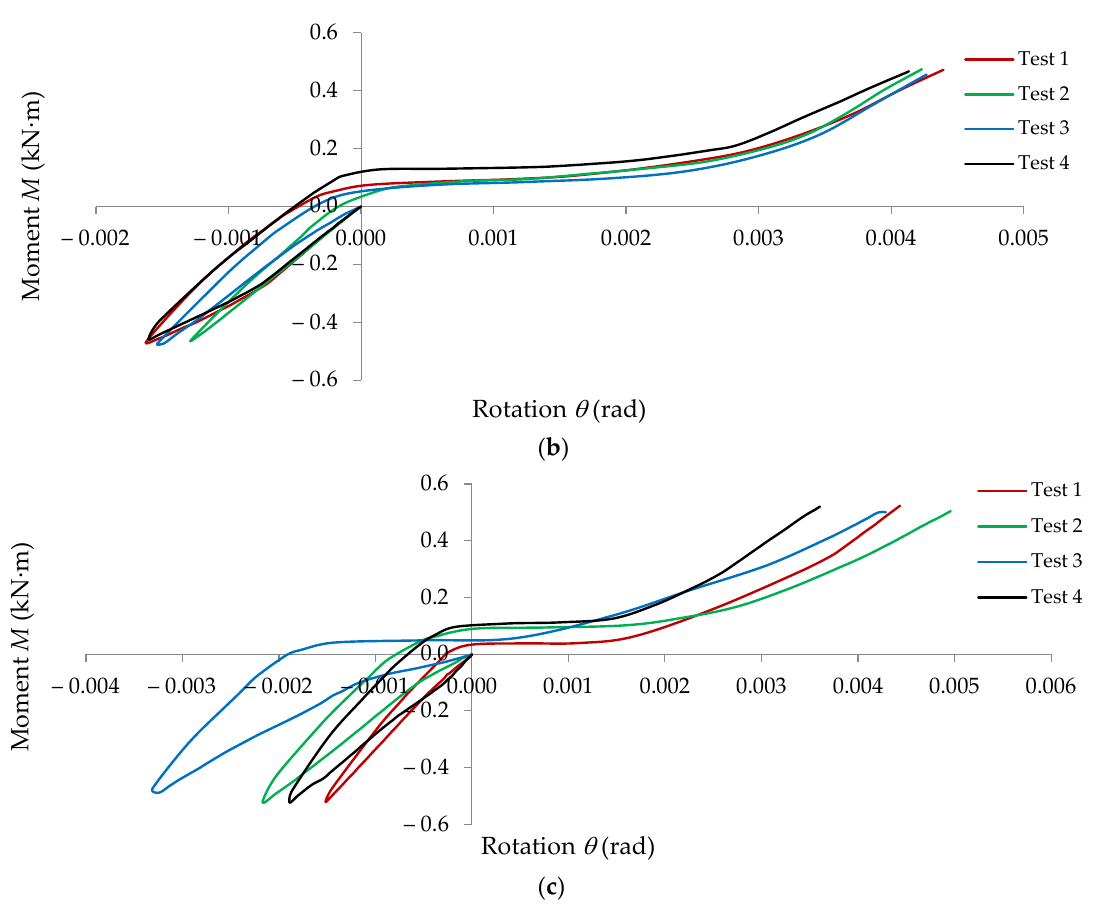
Figure 9. Moment-rotation ( M – θ ) curves recorded in looseness tests for the beam-connector-upright assemblies: ( a ) 0-I-5L; ( b ) 0-II-5L; ( c ) 0-III-5L. The moment-rotations ( M − θ ) curves recorded in bending tests of the three beam-connector-upright assemblies investigated (0-I-5L, 0-II-5L, 0-III-5L) are shown in Figures 10–12, respectively.